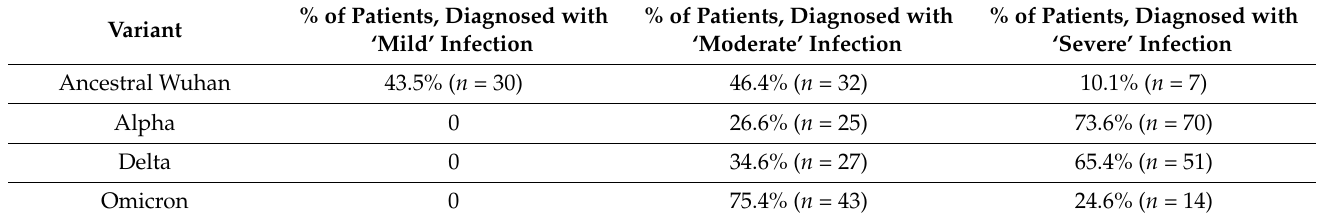
Table 2. Disease severity within